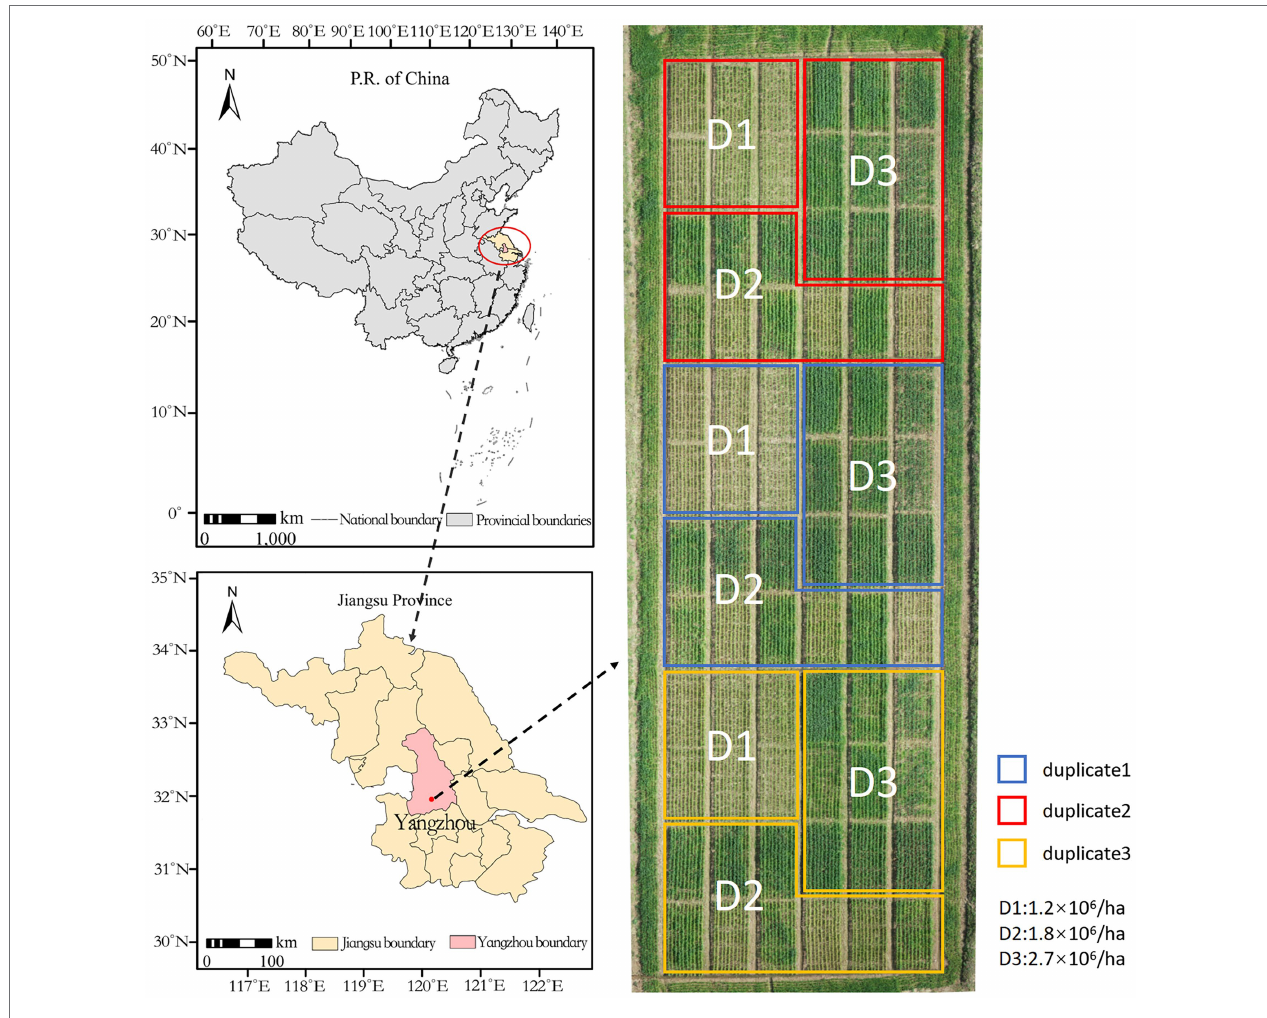
FIGURE 1 | Distribution of test sites and test